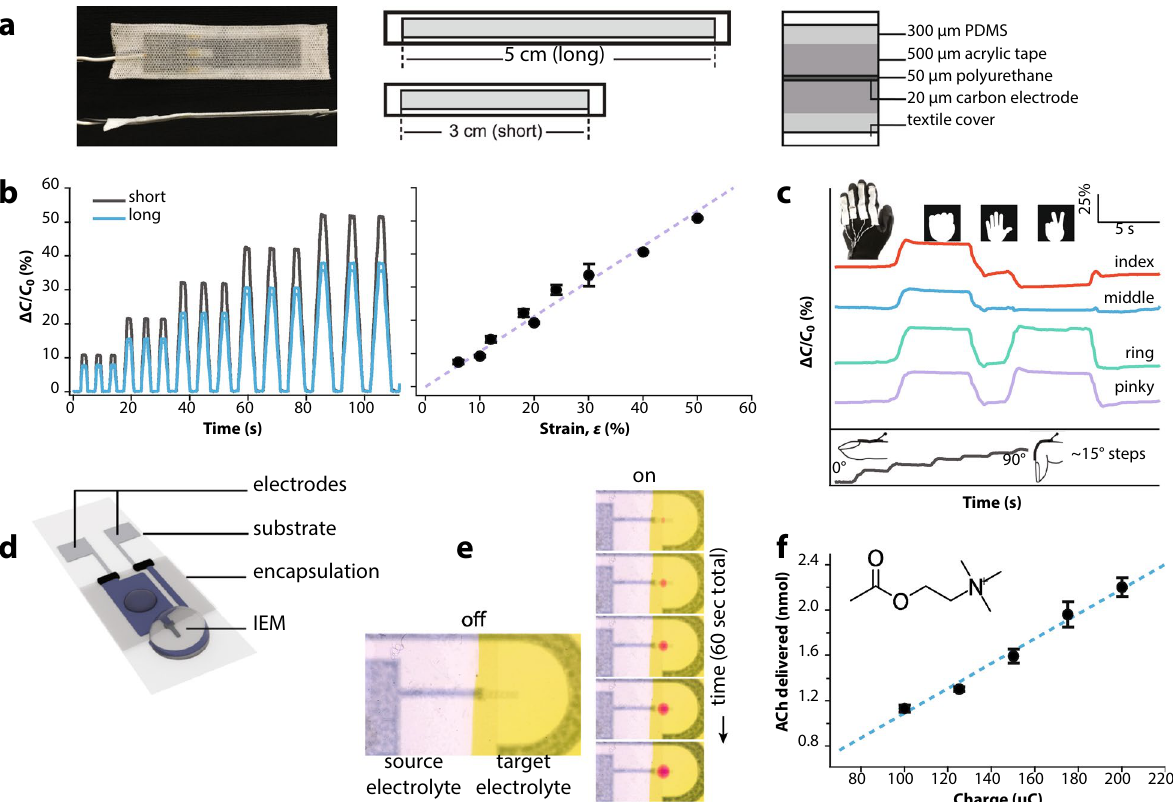
Figure 2. Sensor and actuator/delivery nodes. ( a ) Capacitive strain sensors (short and long types) comprised of a polyurethane dielectric sandwiched by stretchable carbon electrodes encased in rubbers and textiles. ( b ) Relative change in capacitance (Δ C / C 0 ) under repetitive cycling and increased strains, and the extracted linear response with strain up to 50% (2 devices of each length used/shown). ( c ) Signals from gesture capture glove with four individual finger sensors during a game of rock-paper-scissors and for incremental finger bending movements. ( d ) Illustration of an organic electronic ion pump (OEIP) delivery device comprised chiefly of electrodes and an ion exchange membrane (IEM), encapsulated on a flexible or rigid substrate. ( e ) Visualization of ion delivery by transportation of H + from a source to a target electrolyte containing a pH indicator. The proton gradient increased and diffused radially away from the outlet during operation (3 V, on for 1 min). ( f ) Delivery of the neurotransmitter acetylcholine (ACh + , chemical structure inset) controlled by a portable driver unit (measuring charge as integrated current) compared to measured ACh +